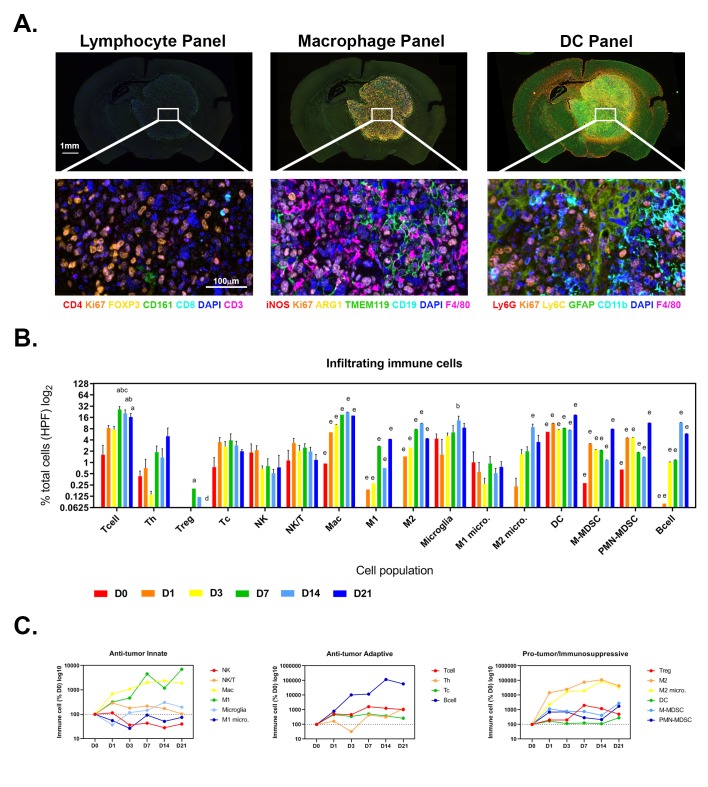
Tumor immune cell infiltrate.(A) Whole slide scans (4x) and MSI spectrally unmixed and pseudo-colored micrographs (20x) of the three immune cell panels for lymphocytes, macrophages and DC populations in the tumor infiltrate. (B-C) Quantitation of immune cell phenotypes in HPF for each murine brain (N = 6 brains per time point). Data are expressed as mean ± SEM per HPF (B) and as mean percentage normalized to day 0 (C). ap<0.05 vs D0, bp<0.05 vs D1, cp<0.05 vs D3, dp<0.05 vs D7, ep<0.05 vs all other time points by One-way ANOVA with Tukey’s multiple comparison test.